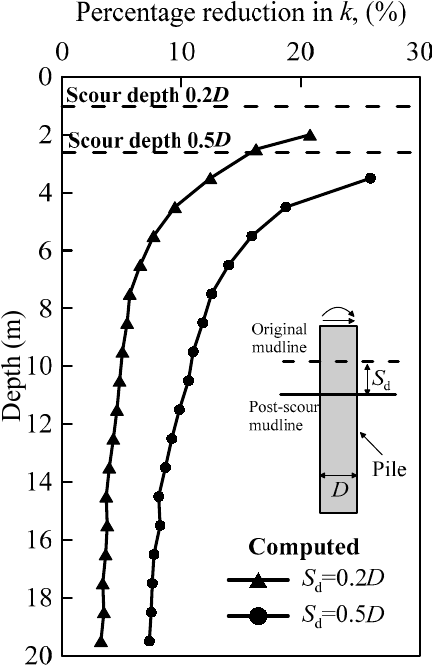
Figure 15. Percentage reduction in the initial sti ff ness of the p-y